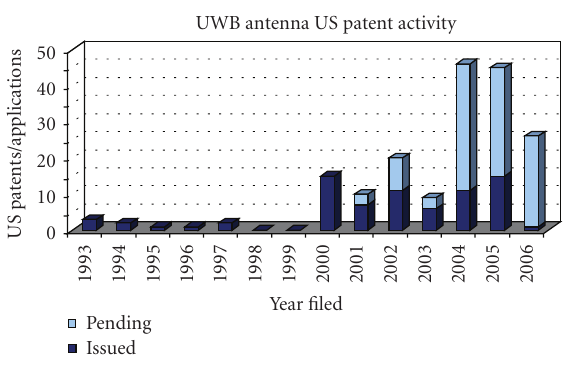
Figure 1: UWB antenna US patent activity by year (1993–2006).